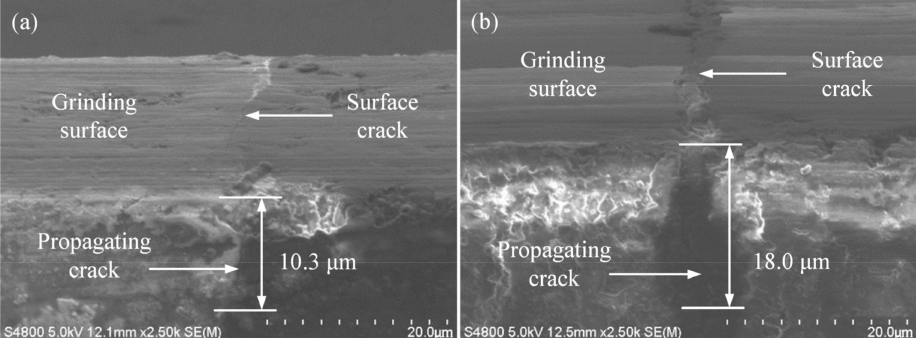
Figure 5. Influence of feed rate on crack propagation ( v s = 38 m/s, a p = 12 µ m): ( a ) v w = 2500 mm/min; ( b ) v w = 5500